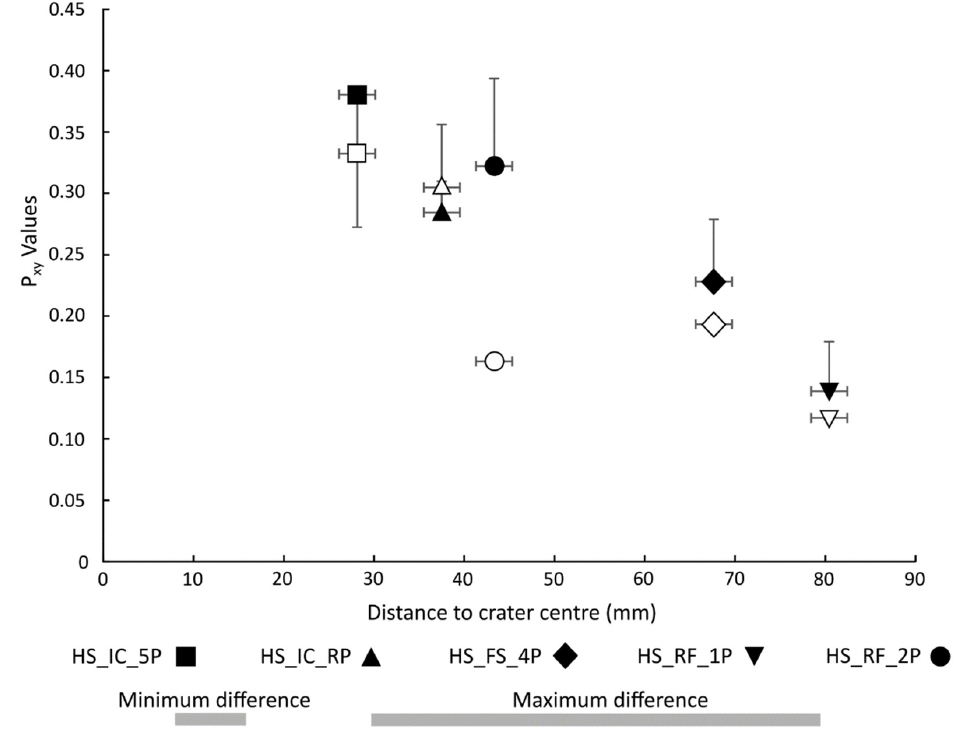
Figure 5. Graph showing the decrease in P 21 (hollow symbols) and P 22 (filled symbols) values with distance from the point of impact. The minimum and maximum differences show how much distance a section can represent in a single value (see Table A1 in Appendix A for values).